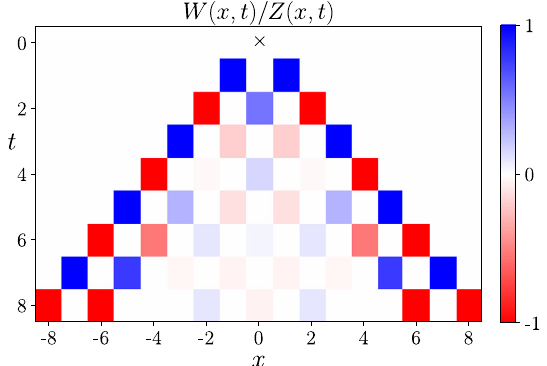
FIG. 10. Weakly entangling gate with x ¼ 0 . 5 [Eq. (72)]: Heat map showing the relative importance of long steps.